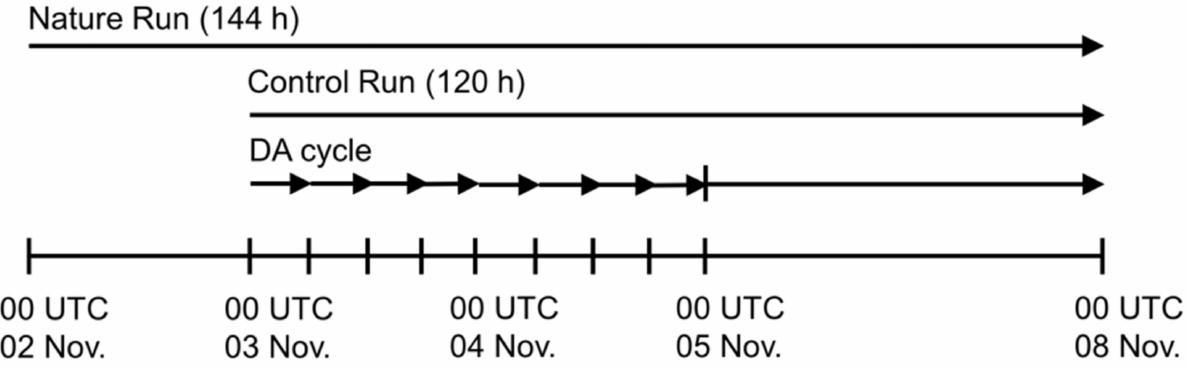
Figure 3. Schematic illustration of the DA procedures by GSI-based EnKF used in this study. Simu- lated conventional observations and MURON observations drawn from the nature run are assimilated in DA